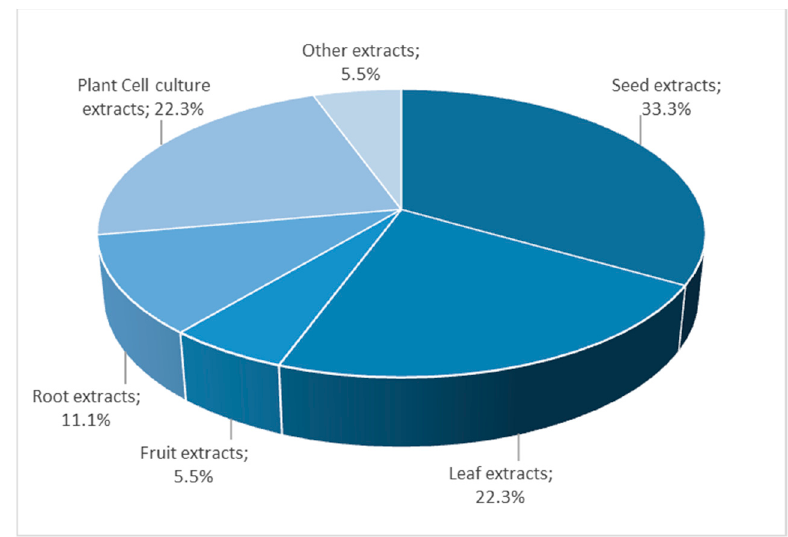
Figure 2. Distribution of extracts of plant origin considered in this study.